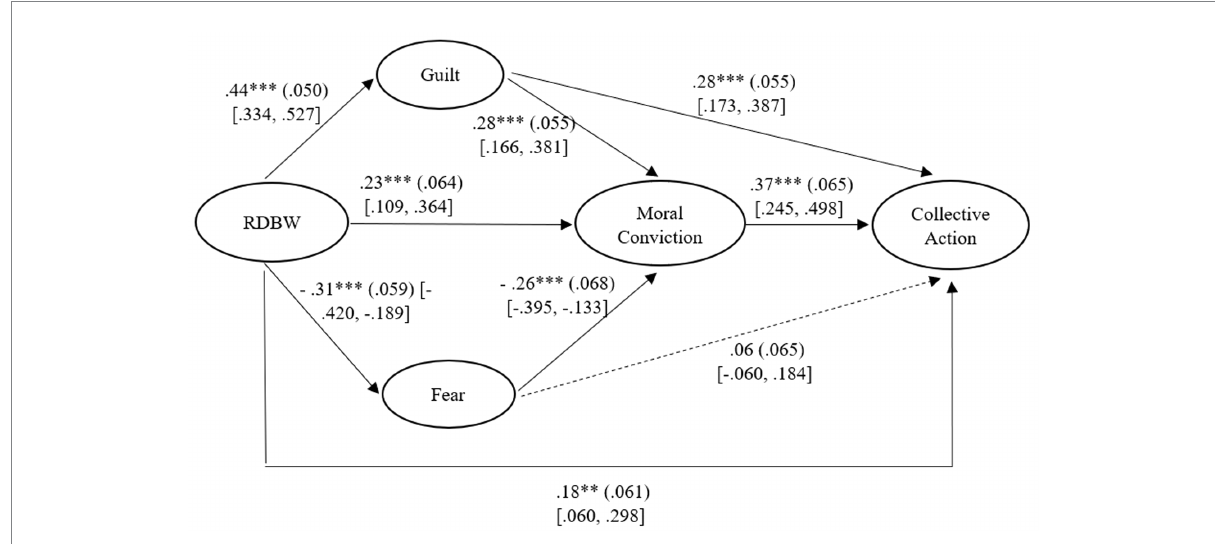
FIGURE 1 Standardized solution of the model testing the relations among RDBW (relative deprivation on behalf of women), emotions, moral conviction, and collective action, with β (SE) and [95% CI]. Political orientation was included in the model as covariate, but it is not shown in the figure. ** p < 0.01. *** p < 0.001.